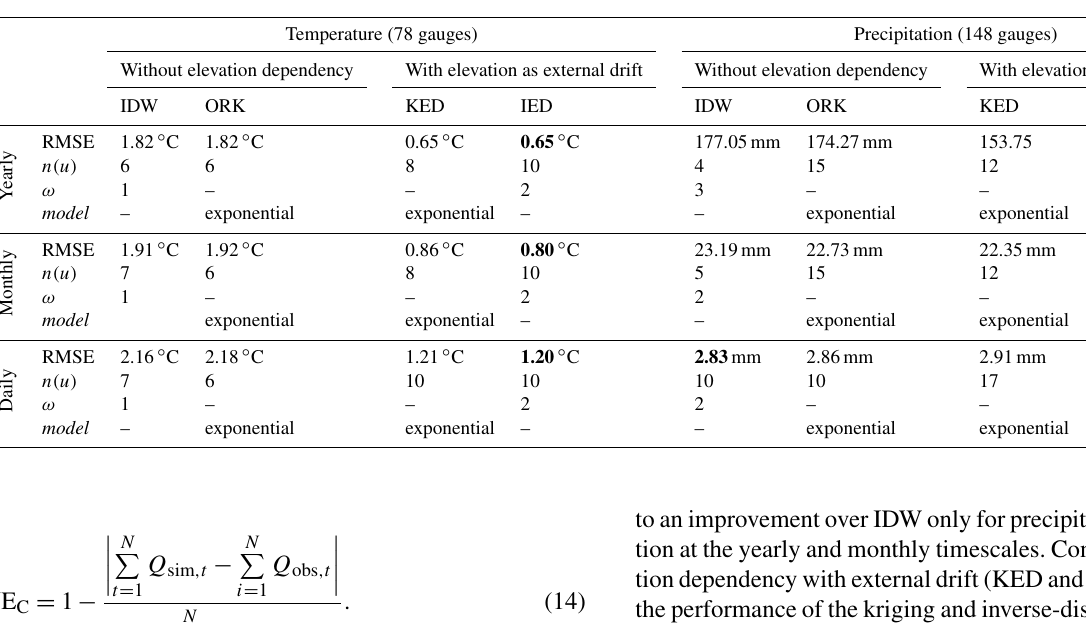
Table 4. Cross-validation of the interpolation methods against yearly, monthly, and daily series from meteorological gauges over the pe- riod 2000–2016. The best efficiency criteria for each analytical timescale and each variable of interest (temperature and precipitation) are in bold. The values of n(u) and ω (for IDW and IED) and of n(u) and model (for ORK and KED) represent the interpolation parameters, which were optimized using the leave-one-out procedure, as described in Sect.